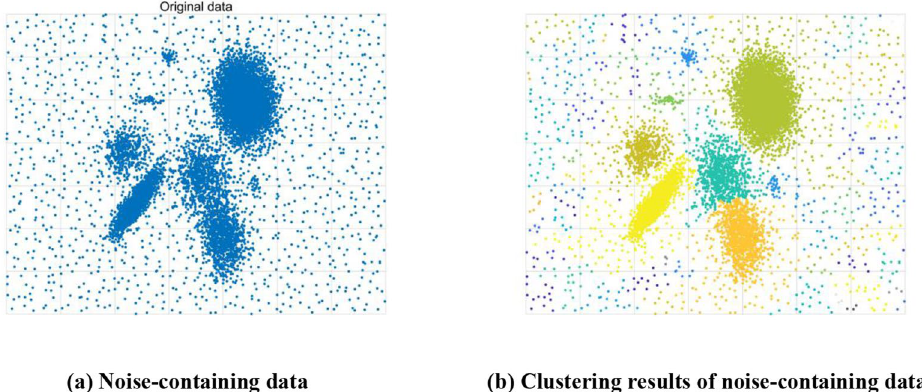
Figure 3. Clustering of a noise-containing 2D Gaussian mixture distribution dataset. ( a ) Noise points were introduced to Case 1. The number of noise points accounted for 11.62% of the whole dataset size. The BCALoD algorithm was used to do cluster analysis for all data, and the d c value in the case was 1.1833. ( b ) That some noise points were clustered into noise clusters, and the other noise points were clustered into real clusters. The number of clusters was